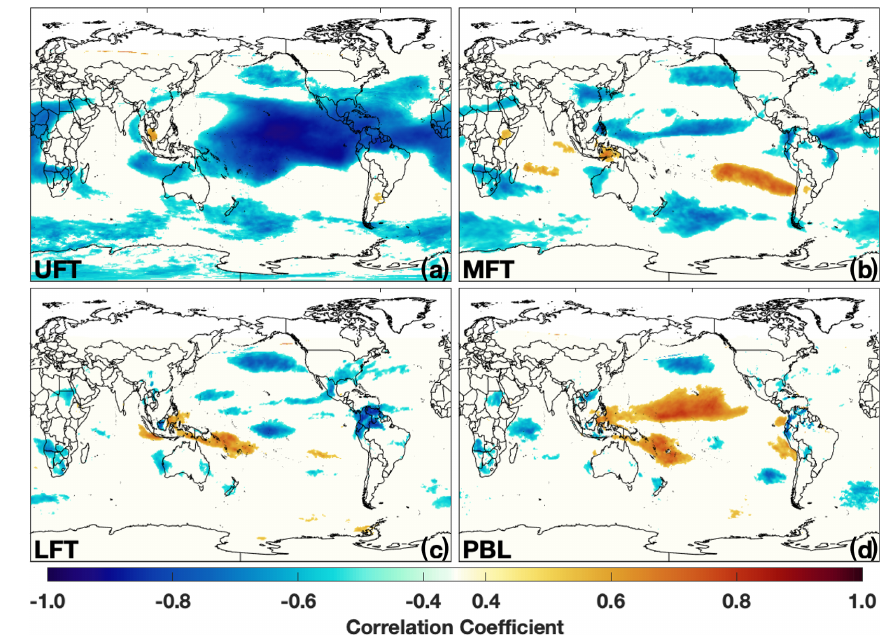
Figure 11. Correlation of OH from MERRA-2 GMI with the MEI for the different atmospheric layers in